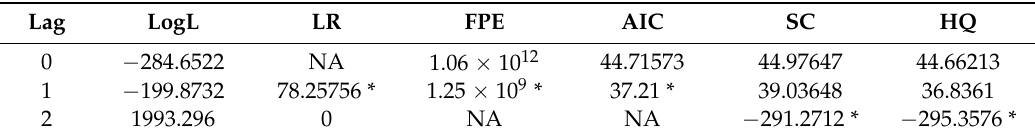
Table 6. Lag order judgment